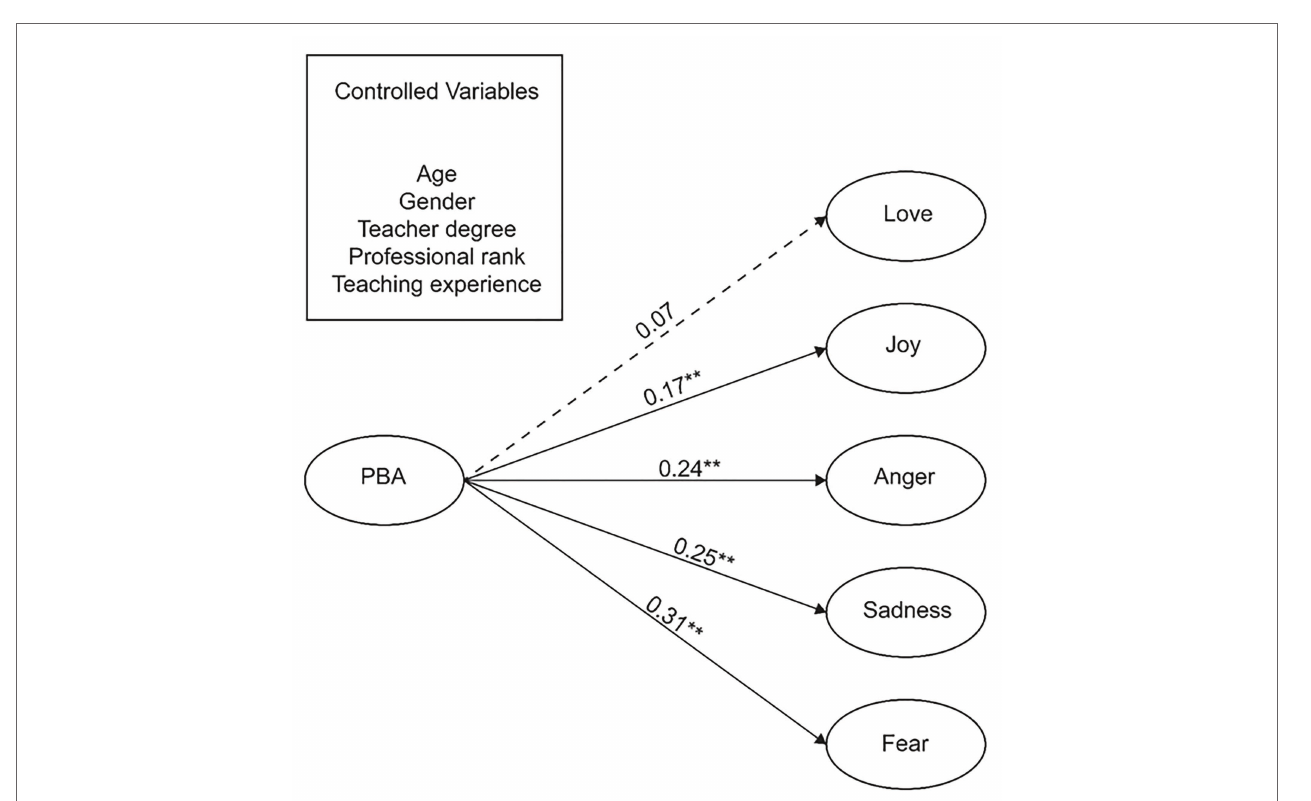
FIGURE 1 | Structural model results showing the path from PBA to teacher emotions. ** p <